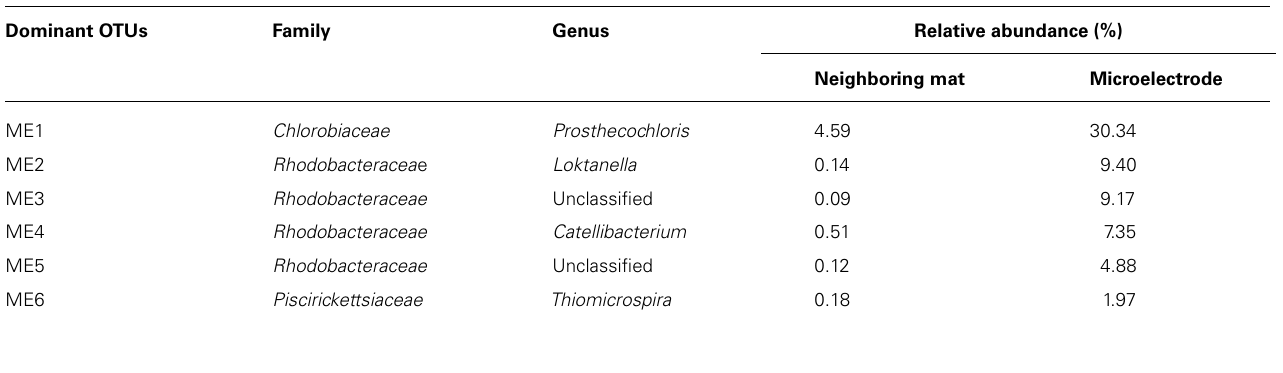
Table 1 | Most abundant OTUs in the microelectrode-associated community. Dominant